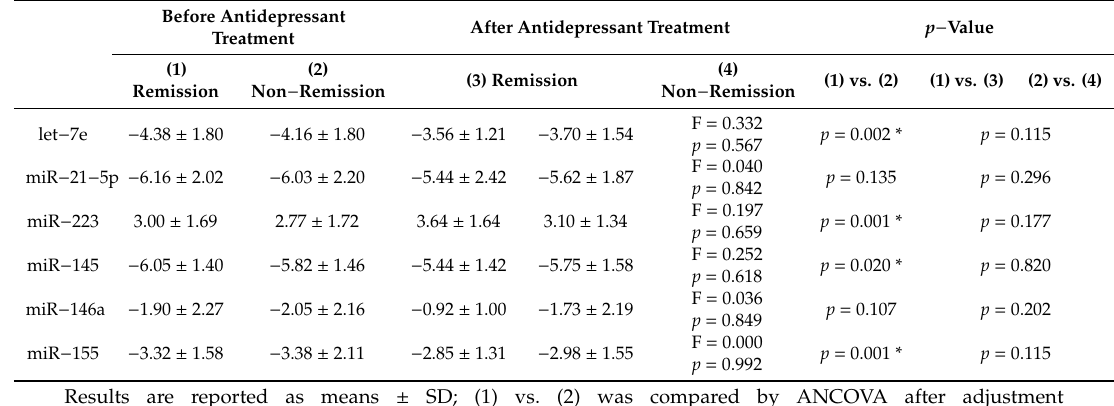
Table 4. Expression in PMBCs of microRNAs negatively regulating TLR signaling before and after treatment with antidepressants in patients experiencing remission ( n = 31) and non-remission ( n = 38).